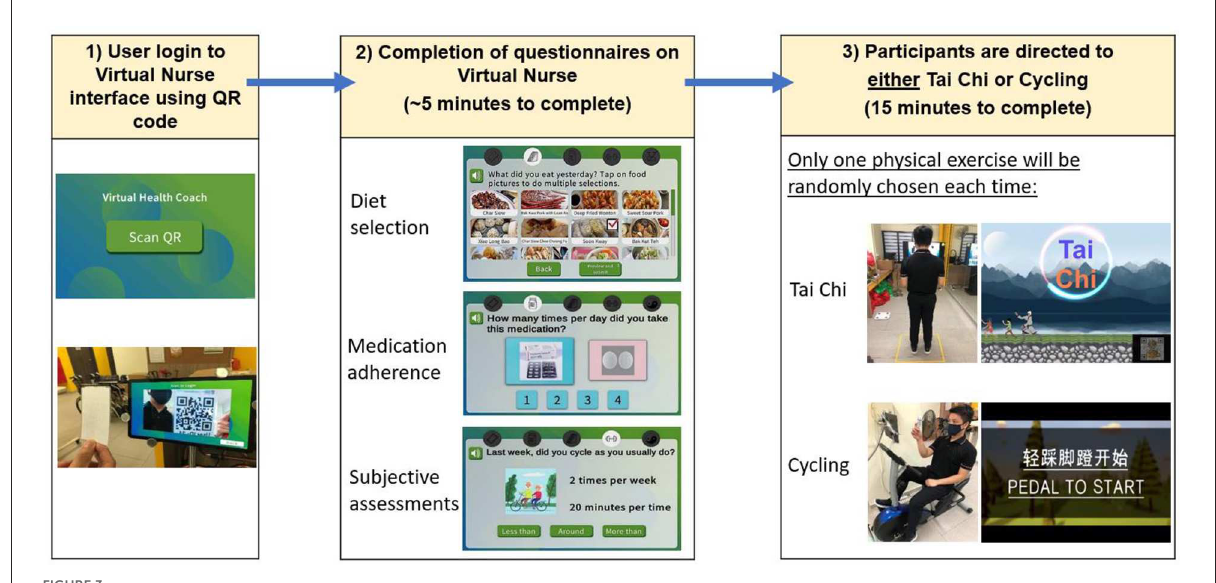
FIGURE3 Overview of user interaction for system for assessment and intervention of frailty (SAIF) session: login to Virtual Nurse interface, followed by completion of diet, medication, and subjective assessment questionnaires, and then being directed to exercise module (either Tai Chi or cycling).